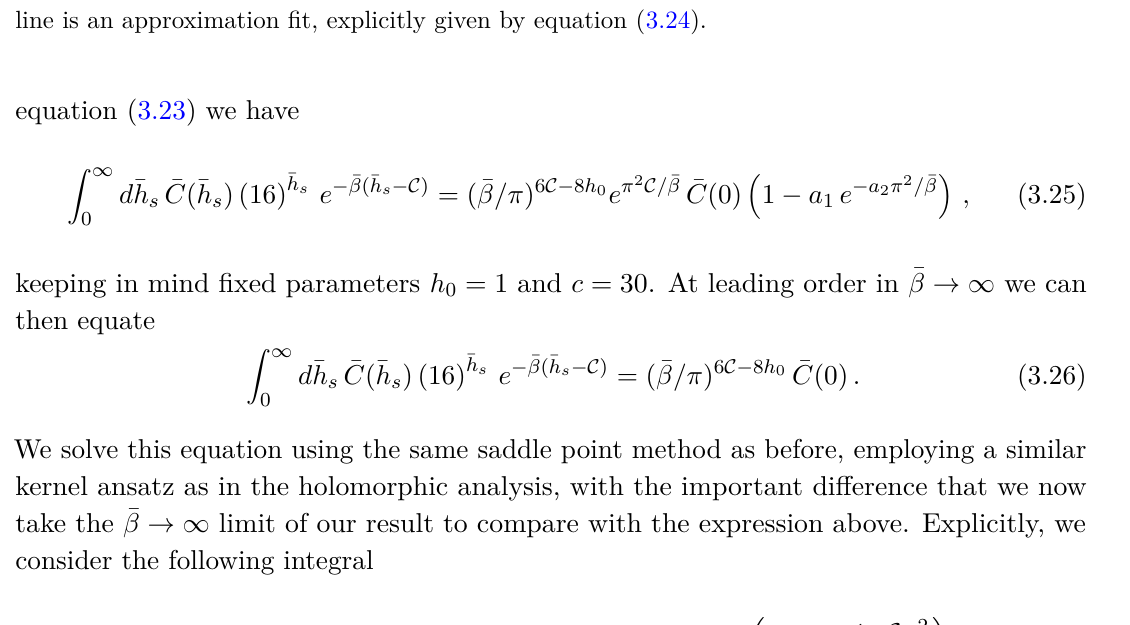
Figure 1 . The dotted line corresponds to the vacuum Virasoro block computed numerically with the aid of Zamolodchikov recursion relations for the particular values c = 30 , h 0 = 1 . The solid red line is an approximation fit, explicitly given by equation